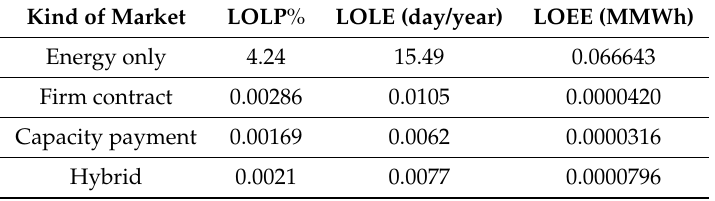
Table 1. Reliability indices of six-bus